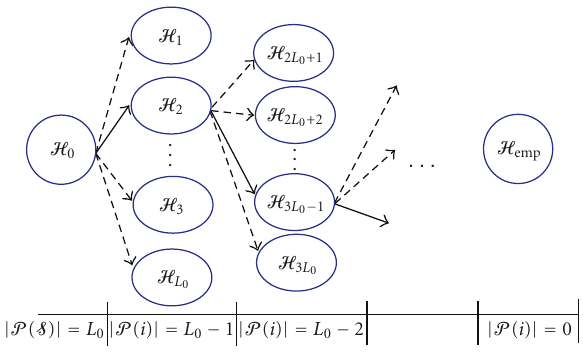
Figure 9: Model selection by evidence